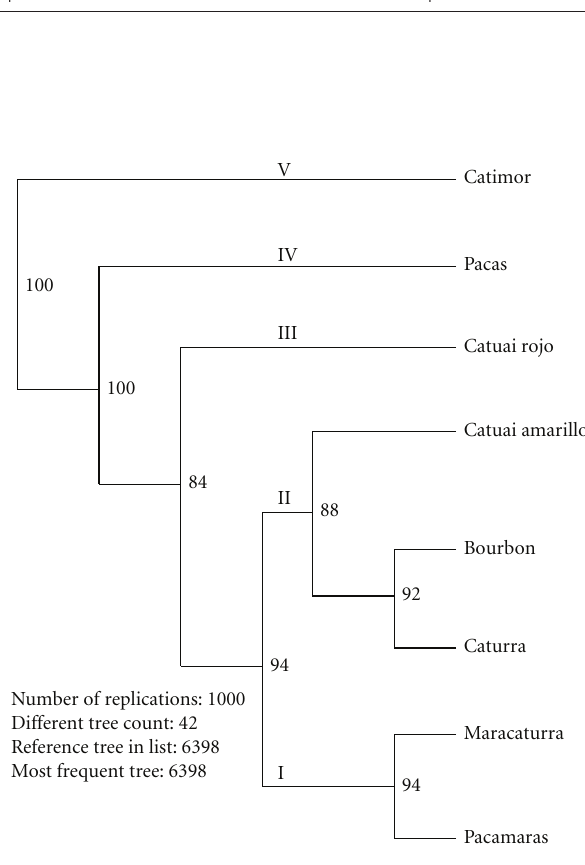
Figure 3: UPGMA phenogram for the eight co ff ee varieties based on Nei’s standard genetic distance. Numbers in front of the branches are bootstrap